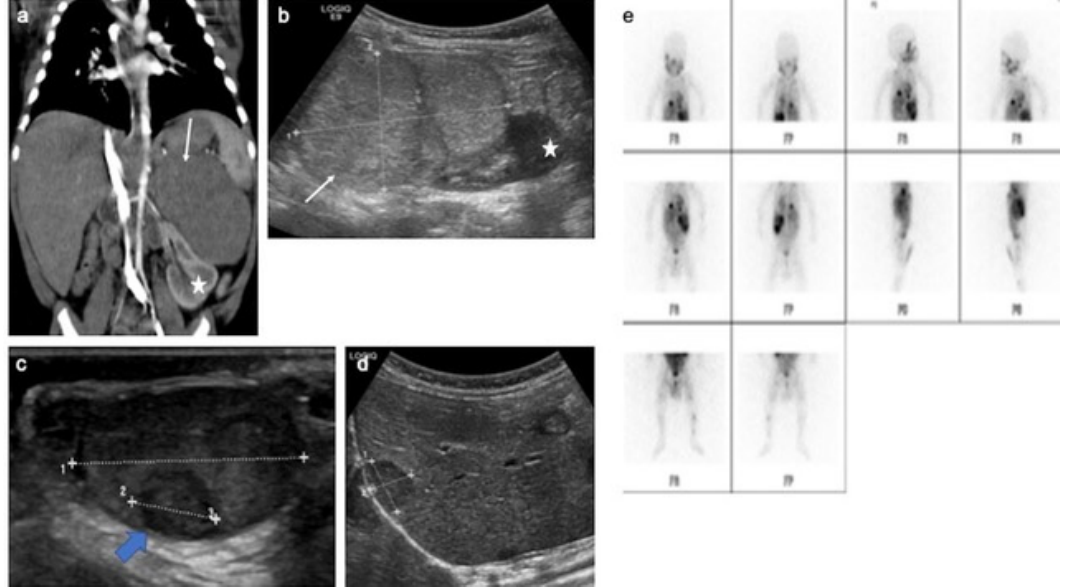
Figure 9. Metastatic neuroblastoma with liver, bone and testis involvement. Contrast-enhanced ab- dominal CT scan ( a ), different views of gray-scale B-mode US focused on the abdomen ( b ), testis ( c ) and liver ( d ). MIBG scan ( e ). Images show a left adrenal tissular mass (white arrow) with a mass effect on the left kidney (star) and intra-testicular (blue arrow) and liver metastases. The testicular metastasis appears as a well-circumscribed hypoechoic and heterogeneous mass. In addition, MIBG scan demonstrates bone extension. US, ultrasonography; MIBG, meta-iodobenzylguanidine. Courtesy of Dr Brisse, Institut Curie, Paris,